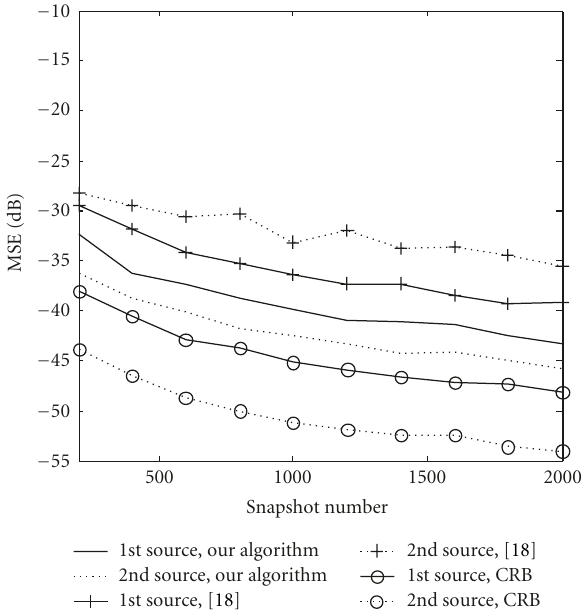
Figure 8: Estimation MSE of the elevations versus snapshot num- ber.